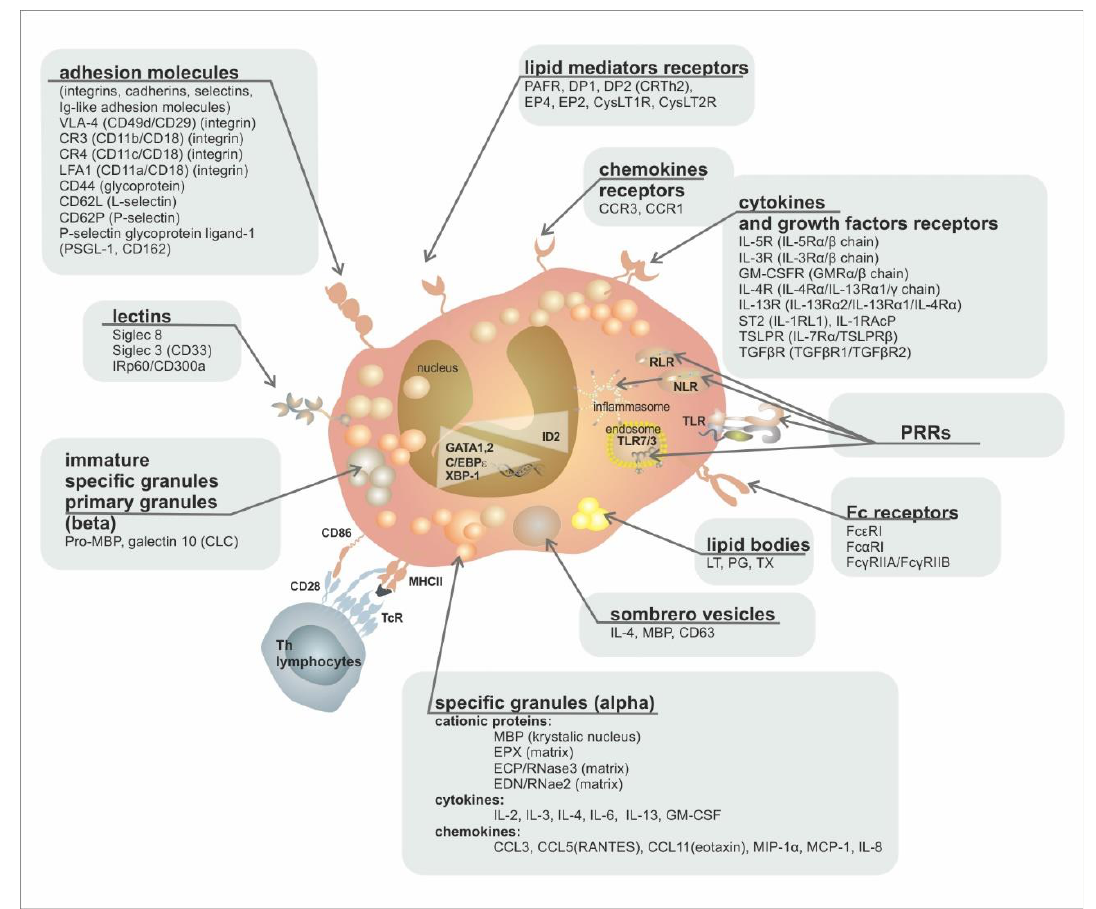
Figure 2. Eosinophil ultrastructure. Abbreviations: MBP — major basic protein, EPX — eosinophil